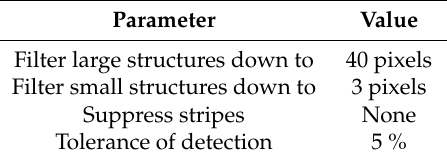
Table 1. Characteristics of the fast fourier transform (FFT) bandpass filter used to correct the background. These parameters are the default ones for ImageJ version